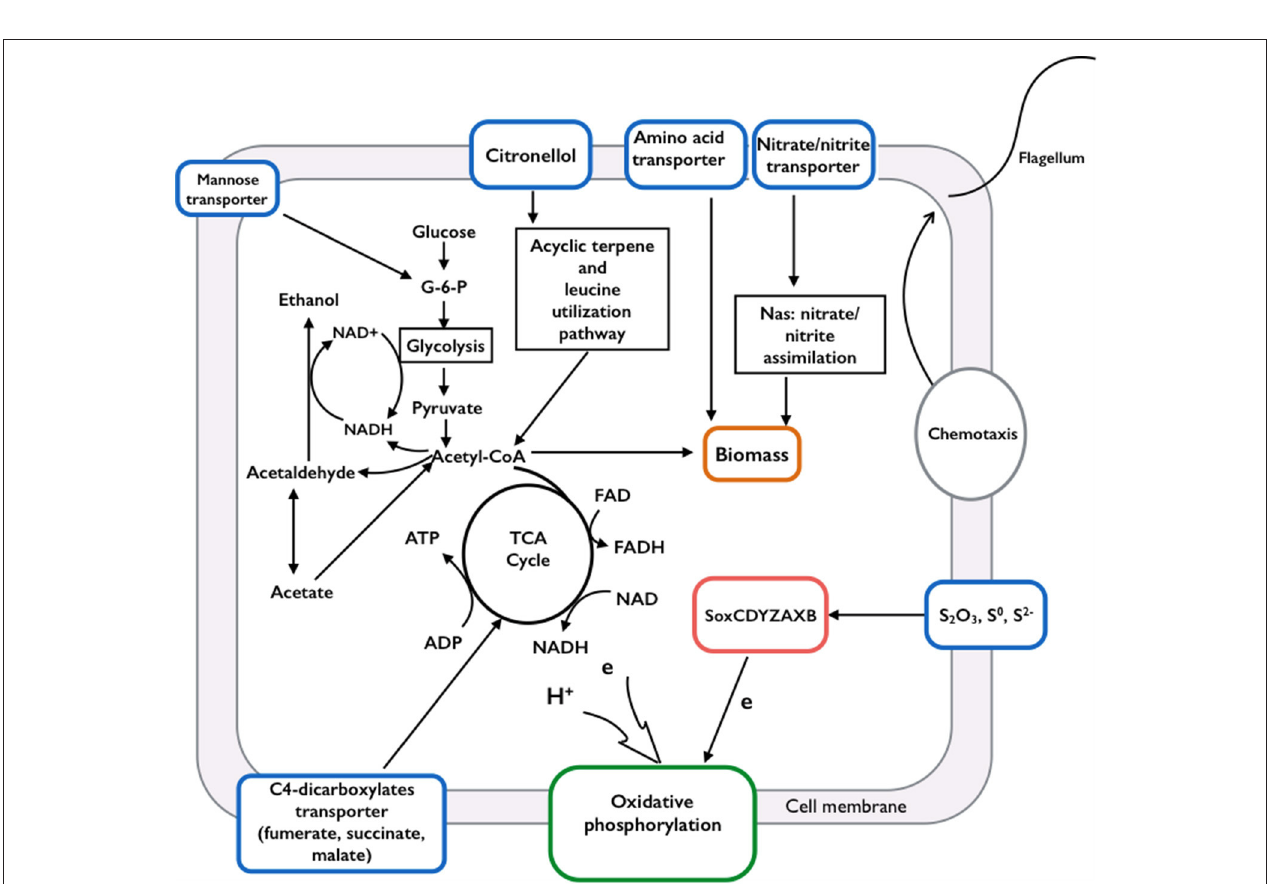
FIGURE 1 | Schematic of the metabolic pathways identified from Limnobacter sp. M12. Genome analysis suggested that Limnobacter sp. M12 is able to utilize organic carbon and nitrogen sources through glycolysis, the citrate cycle, acyclic terpene, leucine utilization pathways, the nitrate/nitrite assimilation system, and their associated transport systems. Through carbon metabolism, the generated electrons and NADH could support energy conservation via ethanol fermentation or oxidative phosphorylation. The electron could also be derived from a sulfur-oxidizing system ( soxCDYZAXB ) to the oxygen via oxidative phosphorylation. Limnobacter sp. M12 is motile because it contains genes encoding proteins involved in chemotaxis and flagella movement.